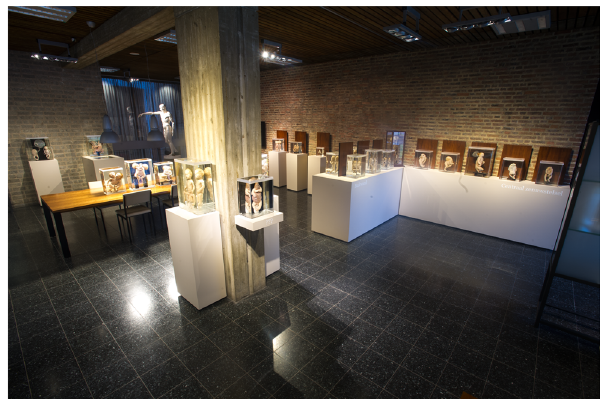
Fig. 1 Photograph of the teratological collection in the Museum for Anatomy and Pathology of the Radboud University Medical Centre in Nijmegen, The Netherlands. The exhibit displays 35 teratological fetuses, 10 specimens of animal teratology, historical books on teratology, 3D models and